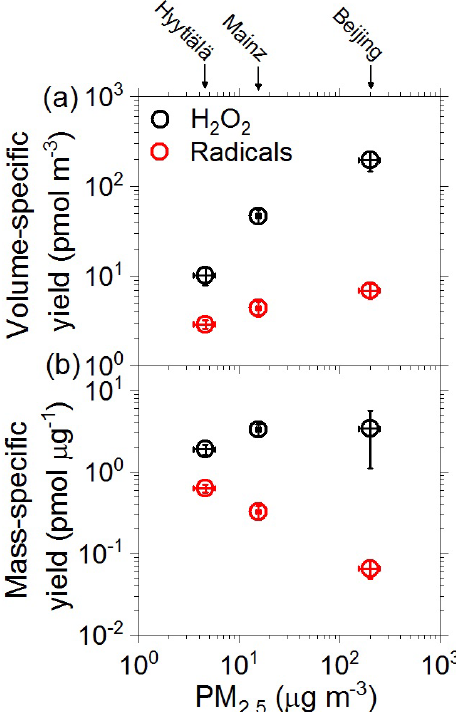
Figure 3. (a) Air sample volume-specific yields and (b) mass- specific yields of aqueous-phase radicals (red circles) and H 2 O 2 (black circles) formed in aqueous extracts of ambient PM 2 . 5 from Hyytiälä, Mainz, and Beijing plotted against PM 2 . 5 mass concen- tration. The error bars represent standard errors of the mean (4– 12 samples per